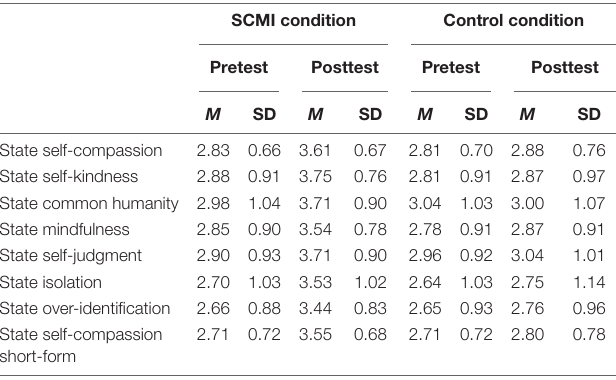
TABLE 8 | Descriptive statistics of the State Self-Compassion Scale at pretest and posttest between conditions. SCMI condition Control